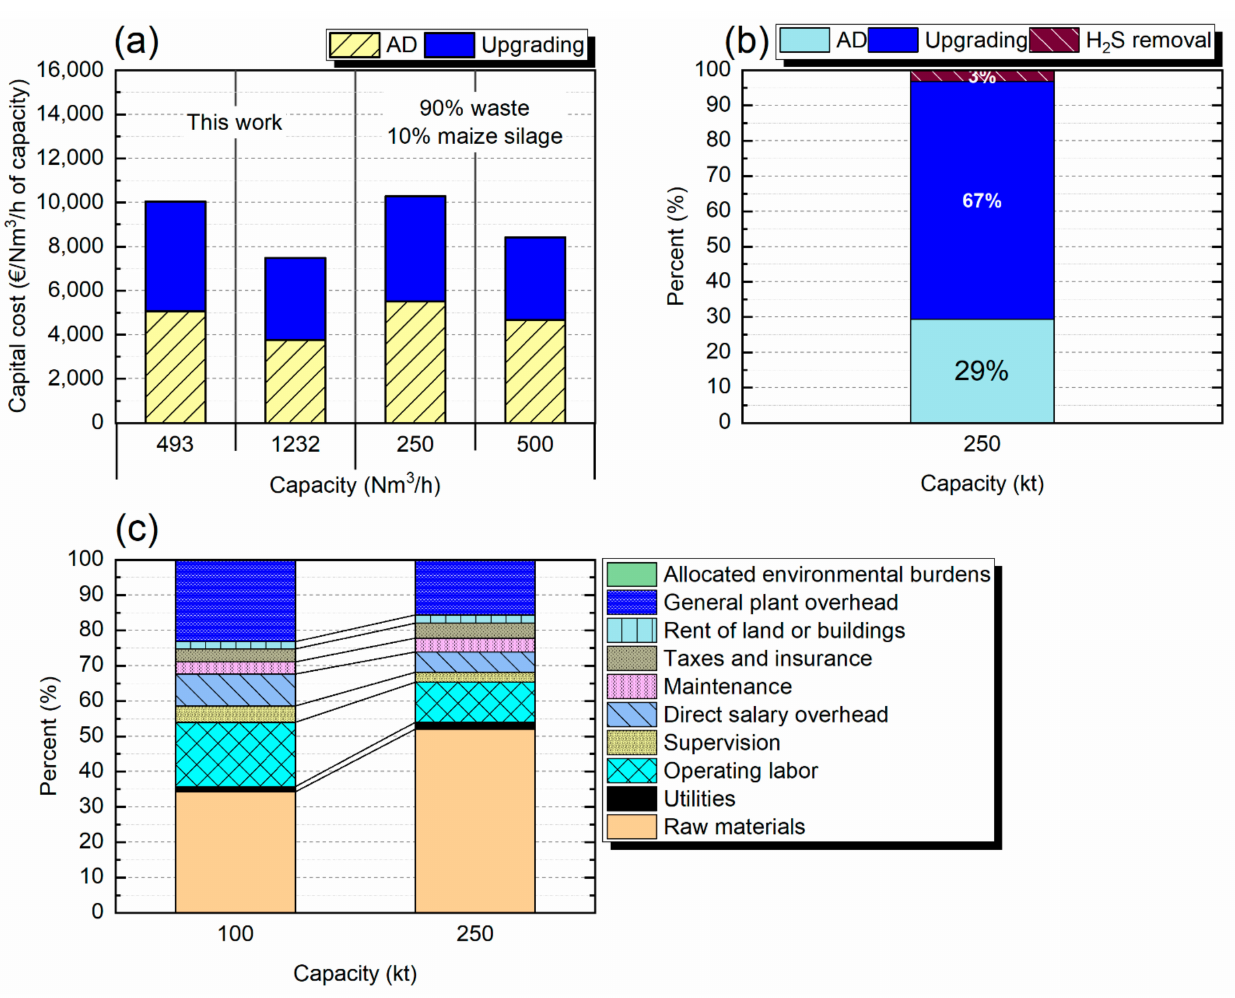
Figure 5. ( a ) Capital cost comparison of scenario 3, with data from biogasworld.com and the base case; ( b ) cost contribution from each plant section; and ( c ) cost breakdown for upgrading between the base case and the larger plant